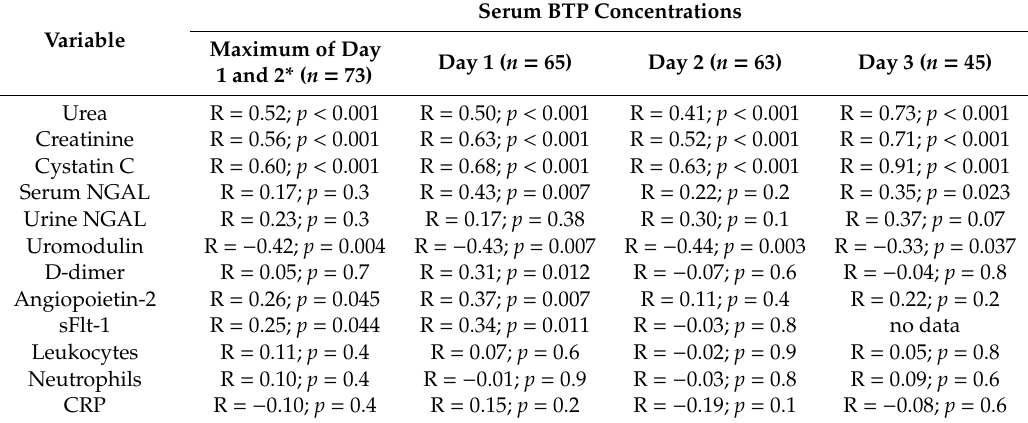
Table 2. Simple correlations between serum BTP concentrations in the whole studied group of AP patients and other markers of kidney dysfunction, epithelial dysfunction and inflammation measured at the specified time-points.